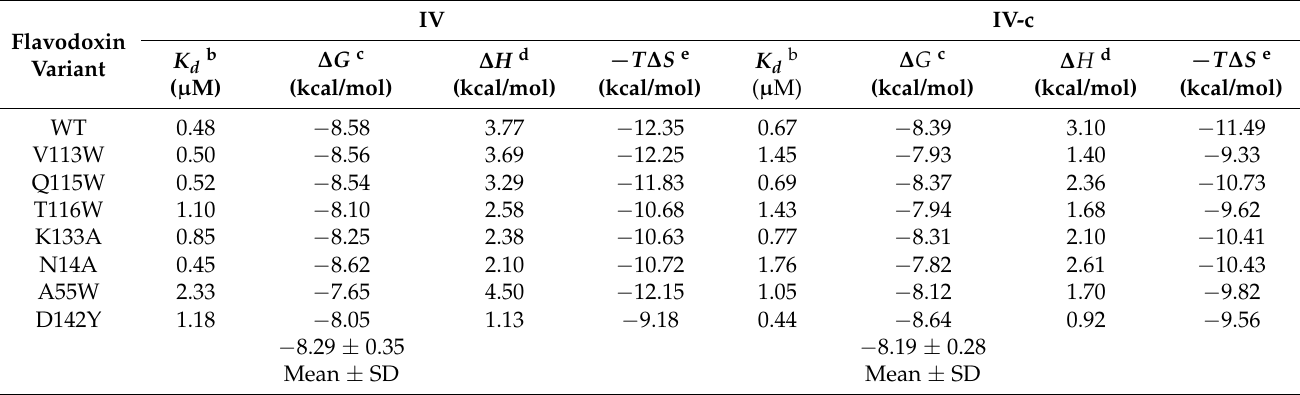
a Obtained from calorimetric titrations in 50 mM EPPS, pH 9. b Relative error in K on ∆ G = RT ln K d . Absolute error in ∆ G is 0.1 kcal/mol. d Absolute error in ∆ H is 0.3 kcal/mol. e Entropic contribution was calculated according to: − T ∆ S = ∆ G − ∆ H . Absolute error in − T ∆ S is 0.3 kcal/mol